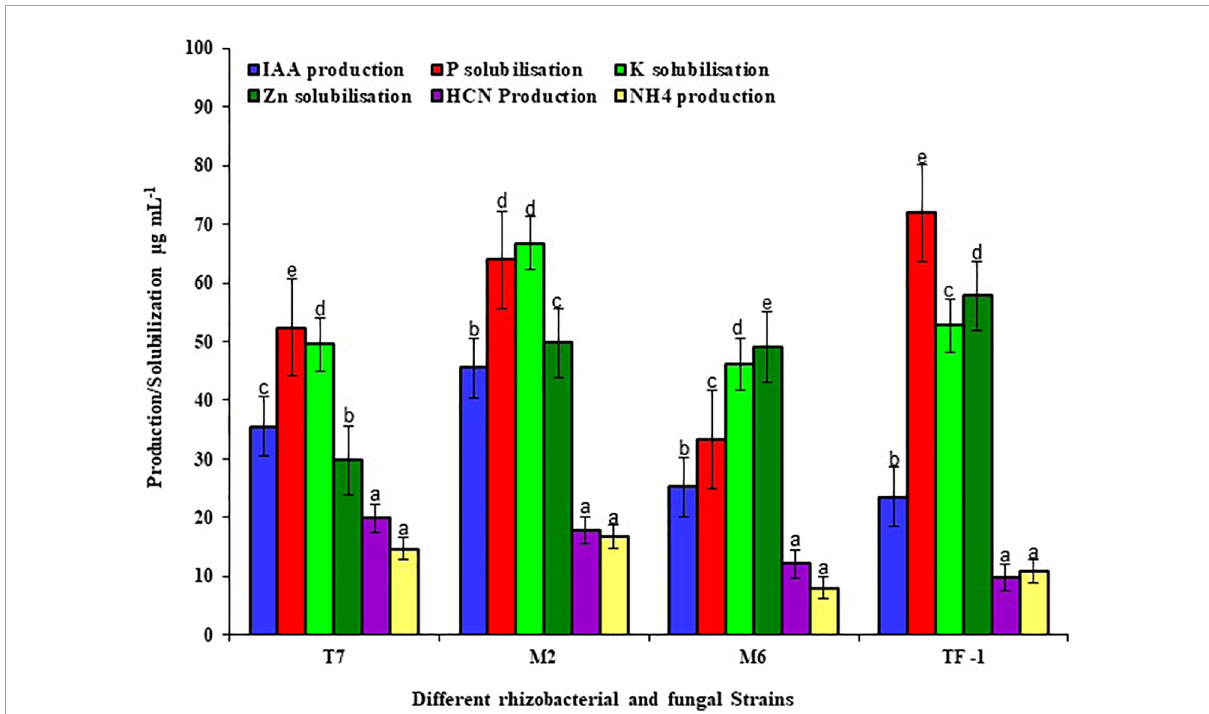
FIGURE1 Different plant growth-promoting properties of rhizobacterial and fungal strains. The results were the average of five replicates ( n = 5). Bars represent standard error. Significant differences based on the analysis variance (ANOVA) are shown by different letters above the error bars, followed by the post-hoc DMRT test ( p ≤ 0.05) using the software SPSS.